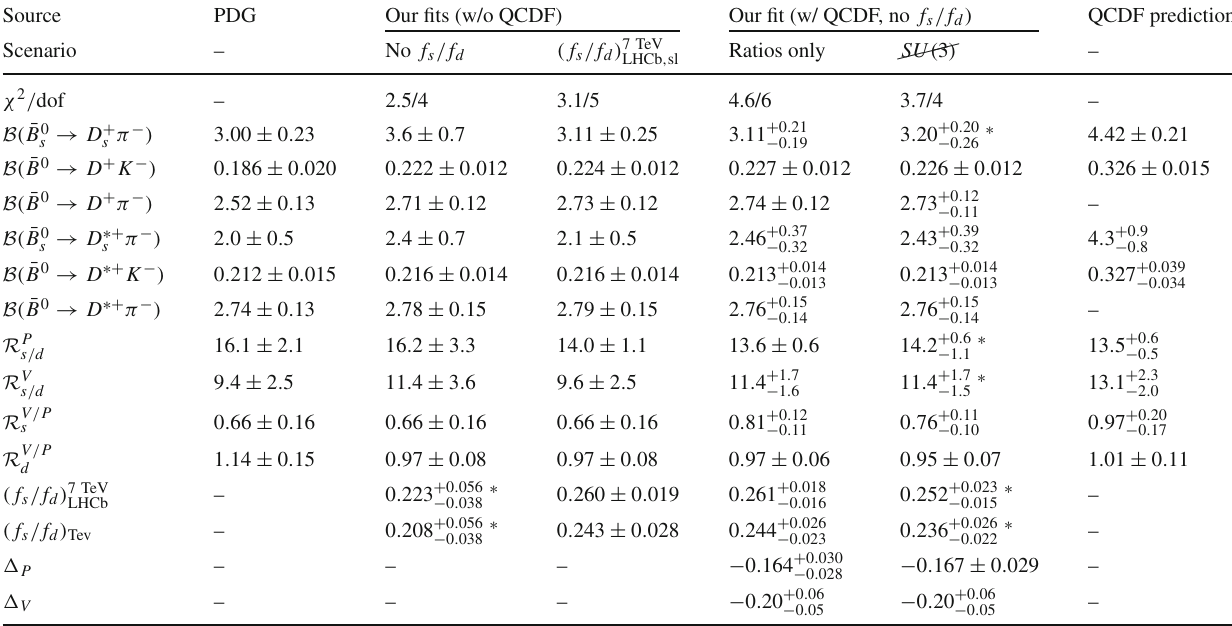
The two fits on the left are not using the assumption that QCDF holds. The two fits on the right are using QCDF input to varying degree, see text. Correlations for these results are available upon request from the